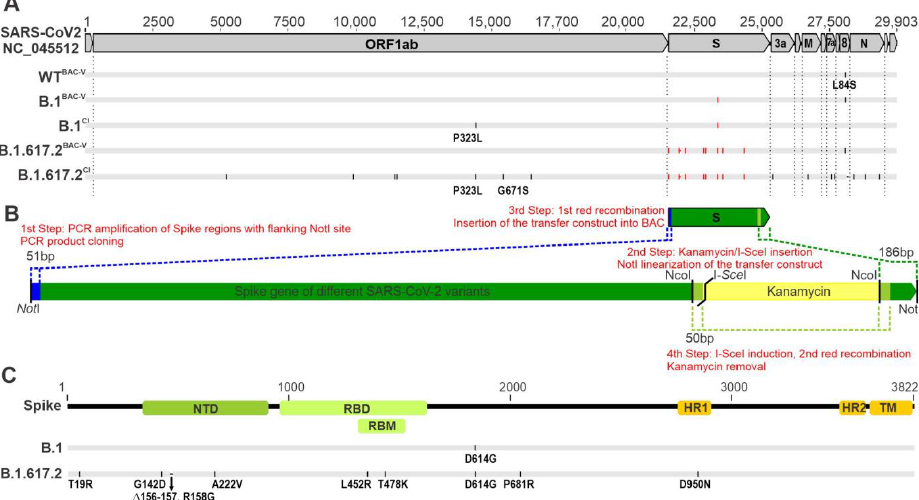
Figure 1. Generation of recombinant SARS-CoV-2 mutants using en passant mutagenesis. ( A ). Genome organization of SARS-CoV-2 Wuhan isolate (NC_045512) is depicted on the top. Open reading frames (ORF) are shown in grey boxes. Dotted horizontal lines mark the ORF borders. cDNA BAC clone of the SARS-CoV-2 USA-WA1/2020 isolate carrying a single amino acid substitution in ORF8 (L84S) and is represented as WT BAC-V . P314L and G662S in ORF1b corresponds to P323L and G671S, respectively, in RNA-dependent RNA polymerase (RdRp). Below, the clinical isolates (B.1 CI and B1.617.2 CI ) and corresponding BAC derived variants (B.1 BAC and B1.617.2 BAC ) generated in this study are shown. Genome wide mutations are indicated in red (spike region) and black (outside the spike region) short lines and are positioned according to the Nanopore sequencing results. ( B ). 1st Step: Spike regions from clinical isolate B.1 and B.1.617.2 (green box) were amplified and cloned into a shuttle vector with flanking NotI restriction sites. 2nd Step: The kanamycin cassette, I-SceI restriction site flanked by 50 bp genomic duplications (light green) were amplified and cloned into the NcoI restriction site within the spike region. NotI-digested transfer construct (~5 kb) was subsequently used for electroporation. 3rd Step: During the first red-recombination step a minimum of 51 bp (N-terminus, blue dotted lines) and 186 bp (C-terminus, green dotted lines) homolog sites facilitated the insertion of the transfer construct into the WT BAC genome. 4th Step: In the second step of Red recombination I-SceI homing endonuclease expression by arabinose induction, mediated double-strand break and the seamless removal of the kanamycin cassette, resulting in BAC mutants carrying the corresponding spike mutations for B.1 and B.1.617.2 isolates. ( C ). SARS-CoV-2 spike protein subunits and domains are shown. N-terminal domain (NTD), receptor binding domain (RBD), receptor binding motif (RBM), heptad repeat 1 and 2 (HR1, HR2) and transmembrane domain (TM). Variant-specific mutations are indicated below.